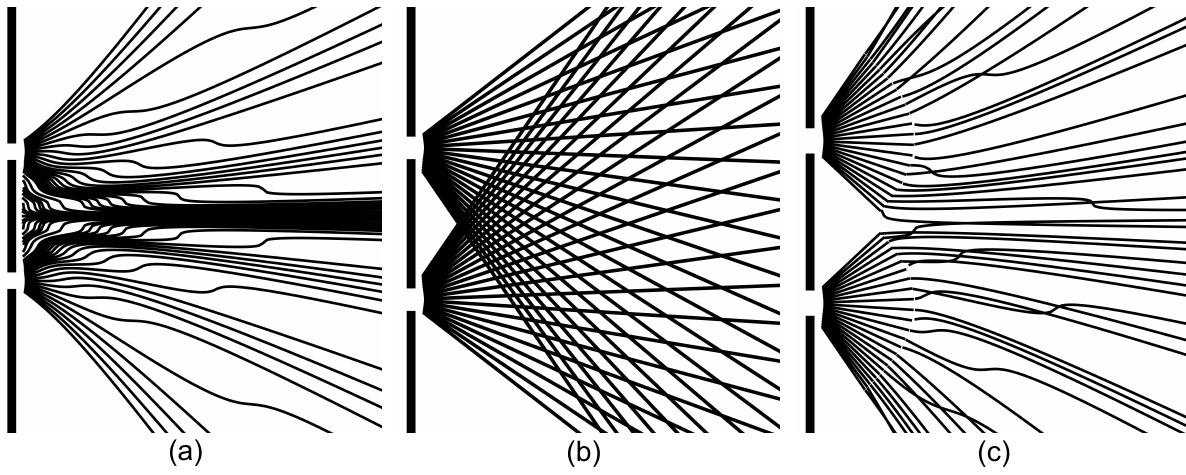
Figure 4: The signal photon follows di ff erent trajectories depending on when the idler photon encounters the quantum eraser. (a) The well-known wiggly trajectories that lead to an interference pattern in a usual double slit experiment. (b) In the case where the idler photon hits the quantum eraser after the signal photon arrives at the screen (which is how the experiment is set up in [8]), the signal photon moves on straight lines. (c) Before the idler photon has encountered the quantum eraser the signal photon follows straight lines. When the idler photon travels to detector D 1 or D 2 , a jump in the guidance relation happens, leading to trajectories as in the interfering